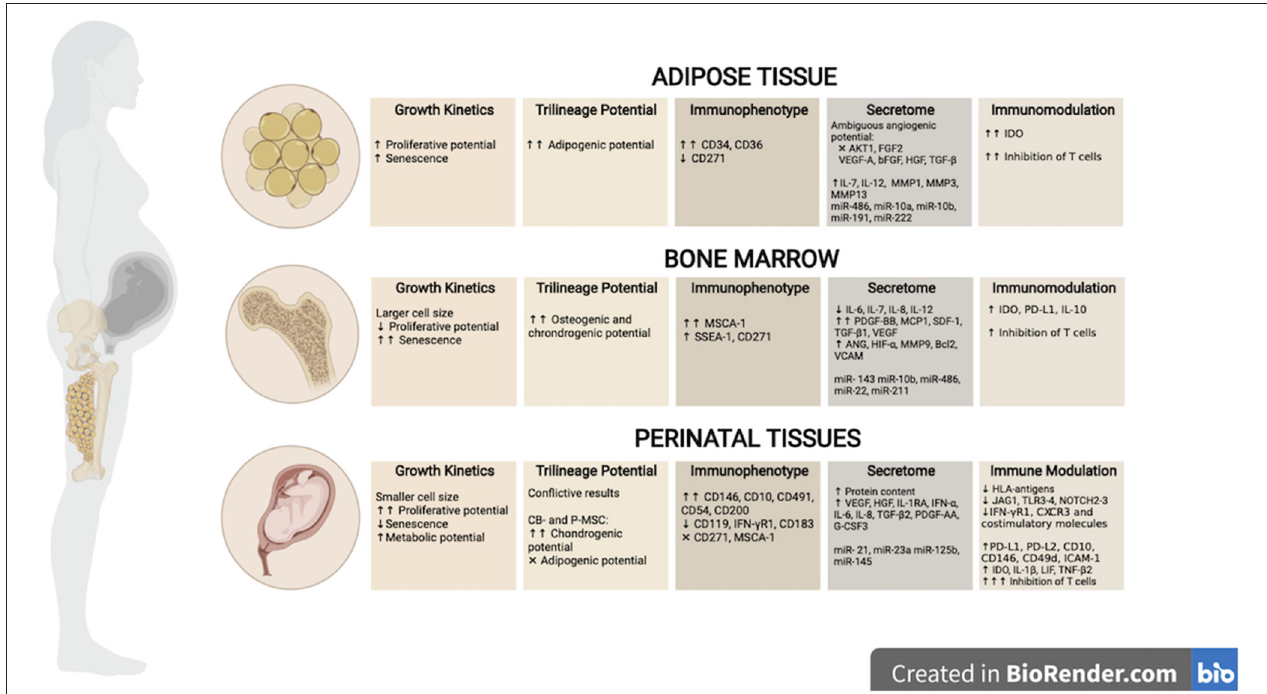
FIGURE 2 | Biological properties of tissue-derived MSCs. MSCs can be isolated from adult tissue sources such as adipose (AT)- and bone marrow (BM), as well as perinatal and/or birth-associated tissues, including amniotic liquid (AM), cord blood (CB), placenta (P) or umbilical cord (UC) tissues. Tissue of origin have shown to impact the biological properties of MSCs. This figure illustrates the main differences described in the literature regarding growth kinetics, differentiation abilities, immunophenotype, secretome, and immune modulation between cell sources. Created in